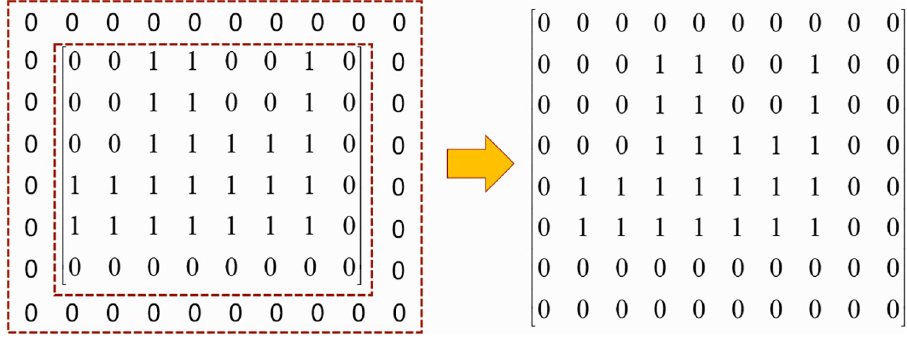
Fig 10. The detection matrix. Padding the periphery of the valid position matrix M vp with a circle of 0 elements to obtain the corner point detection matrix D .